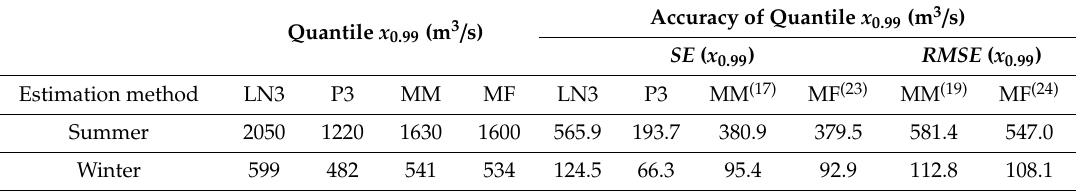
Table 4. Comparison of seasonal quantiles x 0.99 and their accuracy expressed by asymptotic errors obtained from various ways of estimation. The superscripts of aggregation methods MM and MF indicate the equation number which was used for the calculations (for two distributions, i.e., m = 2). Quantile x 0.99 (m 3 /